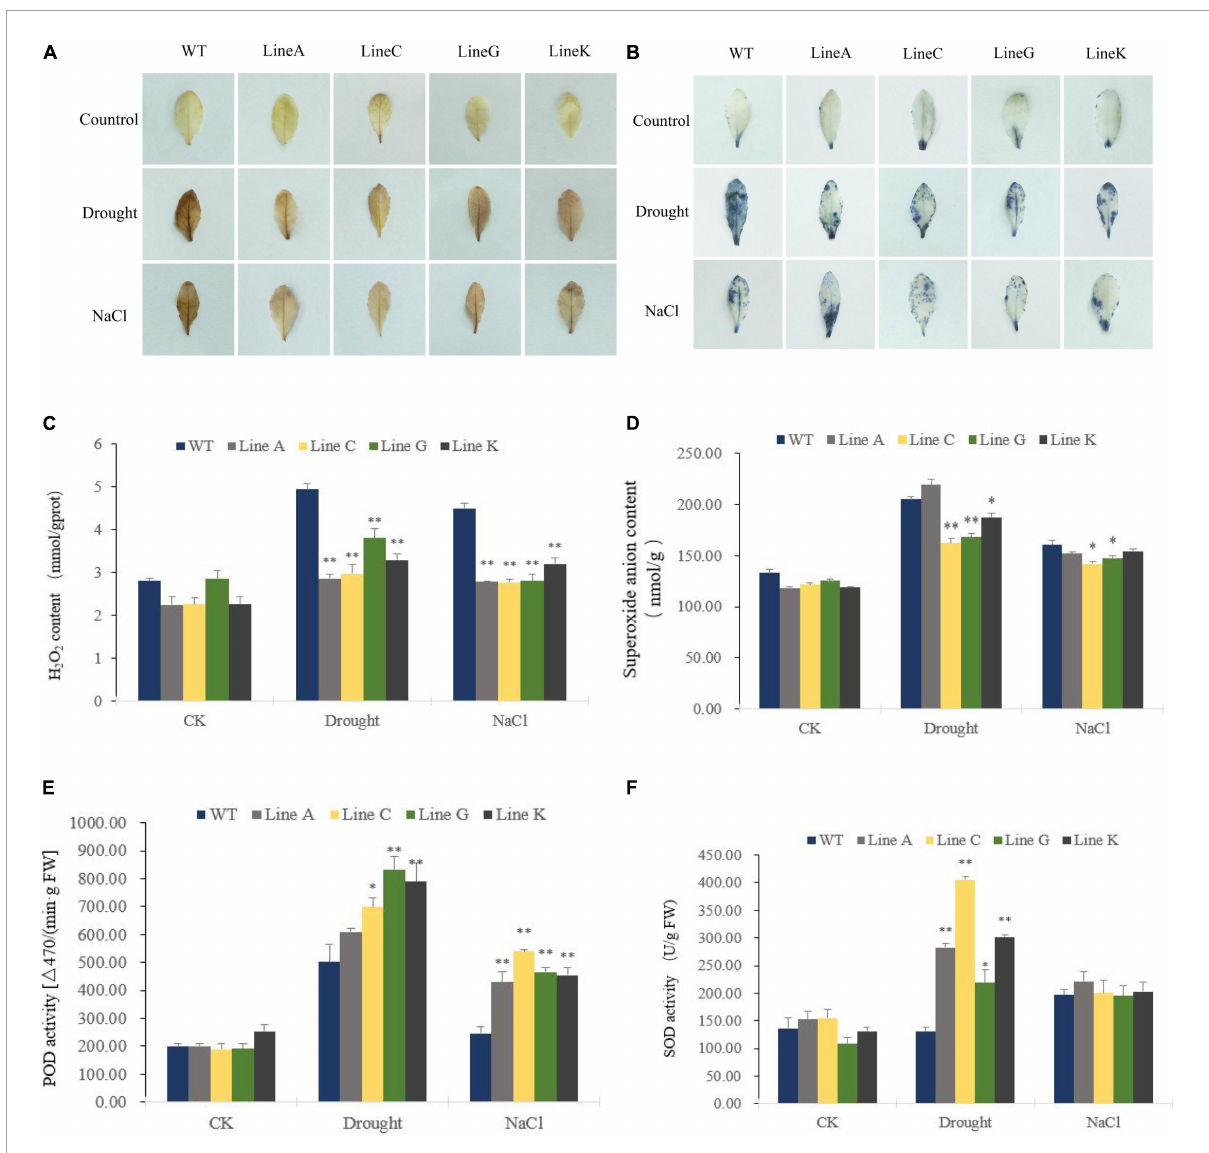
FIGURE6 The effect of drought and salt treatments on reactive oxygen species (ROS) content and antioxidant enzyme activities in the MfWRKY41 transgenic lines and WT plants. H 2 O 2 and O 2 - were detected by histochemical staining with DAB (A) and NBT (B) , respectively. (C,D) Showed the changes in hydrogen peroxide (H 2 O 2 ) content and superoxide anion content between transgenic and WT plants prior to and after stress treatments. (E,F) Indicated activities of peroxidase (POD) and superoxide dismutase (SOD) in the leaves of transgenic and WT plants, respectively. Data are presented as mean and SD values of three independent experiments. Asterisks indicates significant difference ( ∗ p < 0.05; ∗∗ p < 0.01) comparing to